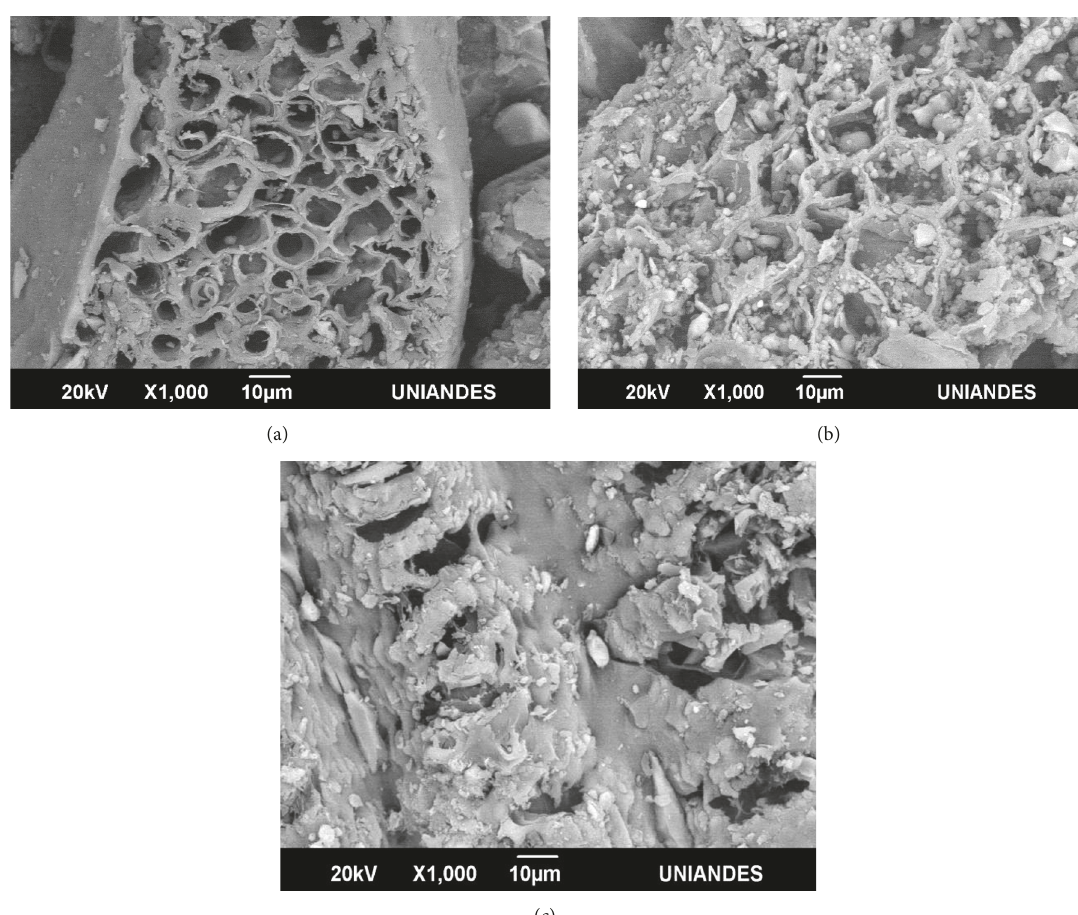
Figure 2: Microphotographs of RHw (a), RHc (b), and RHc300 (c)